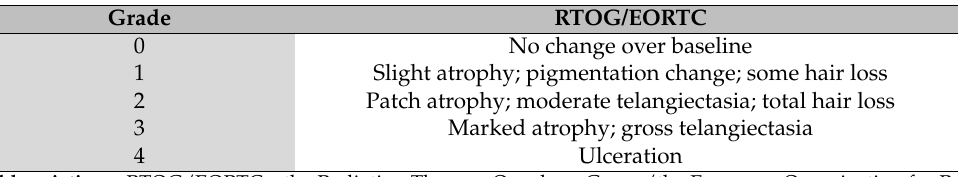
Table 2. The classification of chronic radiation dermatitis according to the Radiation Therapy Oncol- ogy Group/the European Organization for Research and Treatment of Cancer